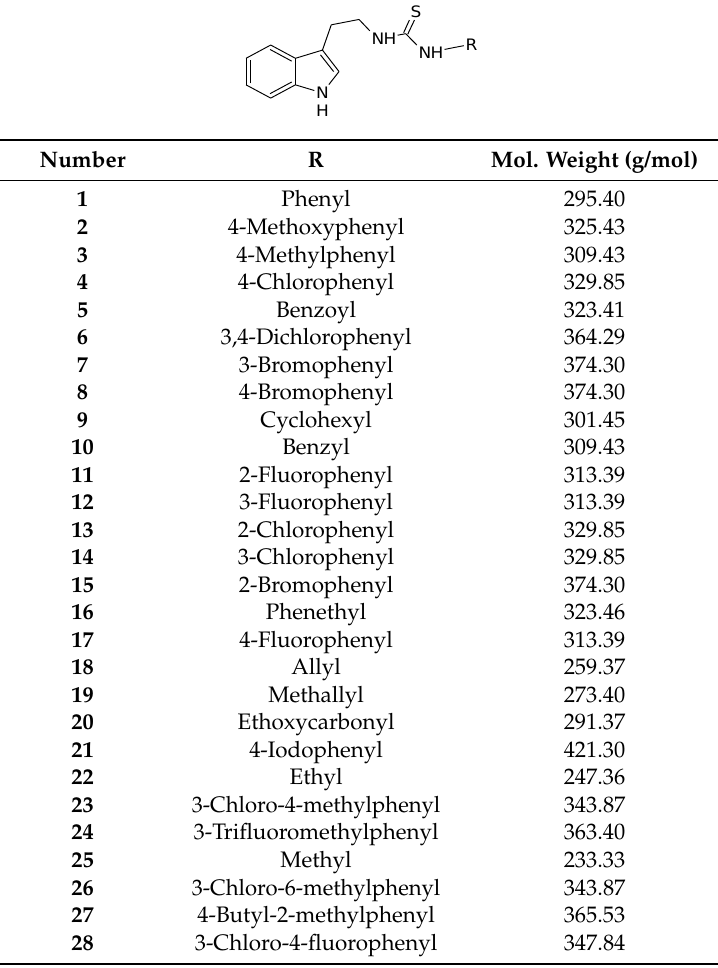
Table 1. Structure and molar weight of the investigated compounds 1–28.